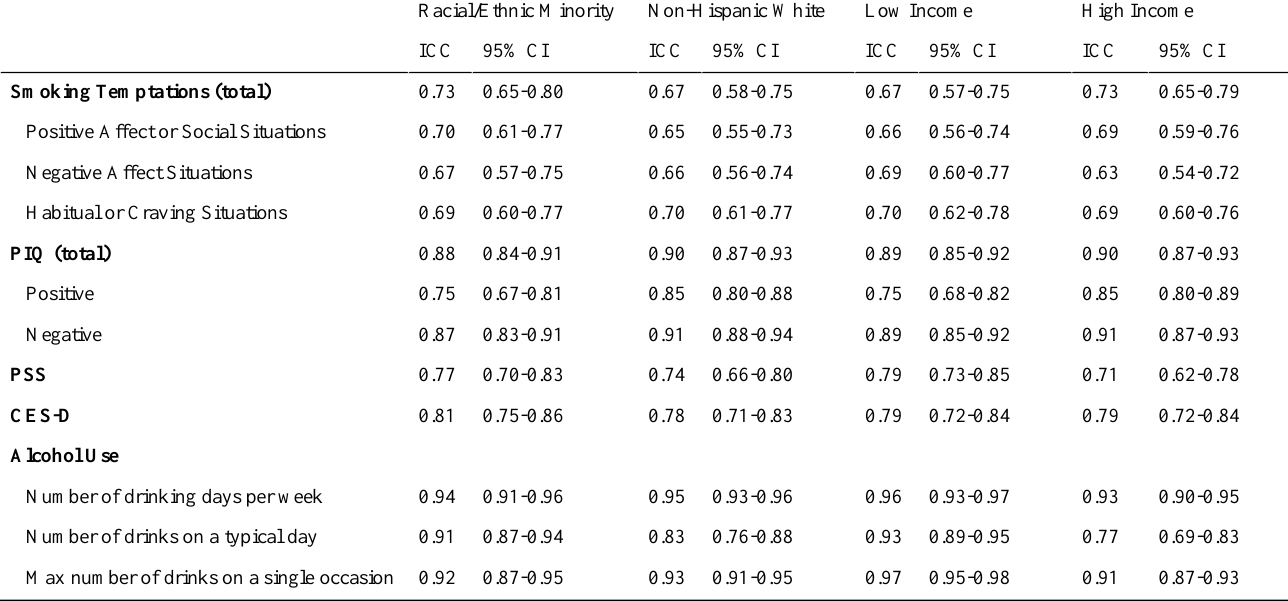
Table 1. Internet–telephone reliabilities of continuous variables by race/ethnicity and income